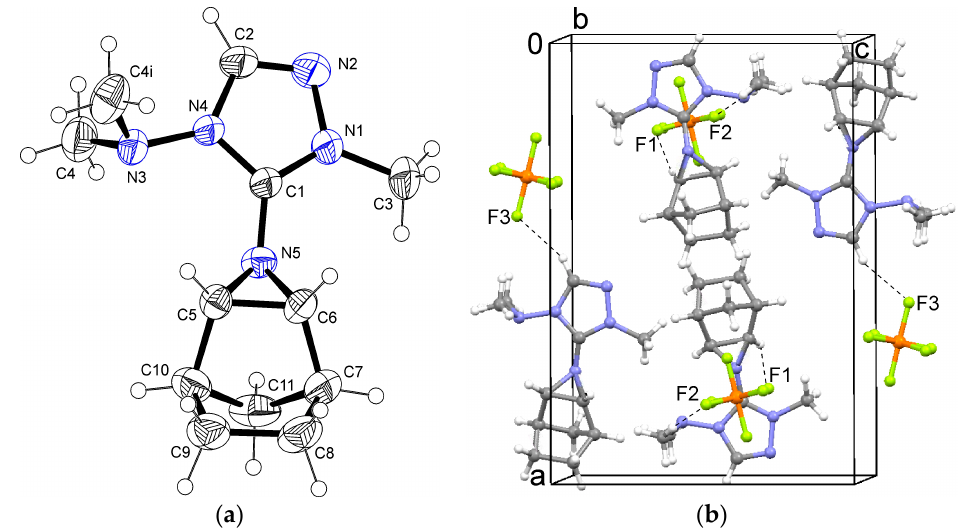
Figure 3. ( a ) O RTEP plot of the cation in 2 ; ( b ) Packing and C–H...F interactions in the crystal structure of 2 . Symmetry operation i: x , 1/2 − y , z .